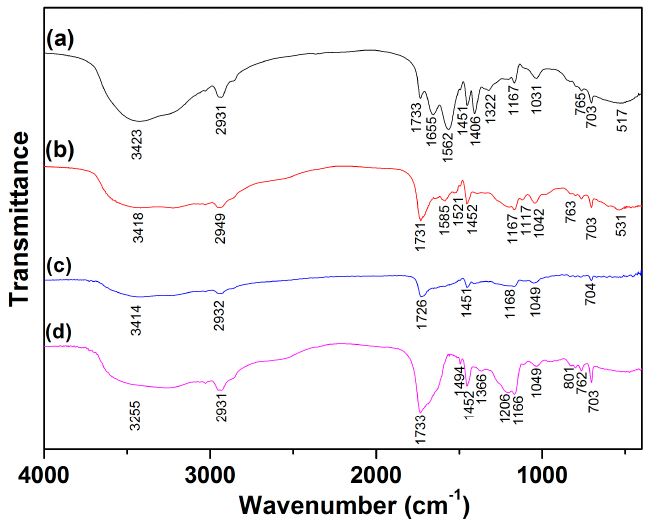
Figure 11. FT-IR spectra of fresh and adsorbed resins. ( a ) Fresh; ( b ) adsorbed at 298 K; ( c ) adsorbed at 328 K; ( d ) desorbed using oxalic acid at 298 K.